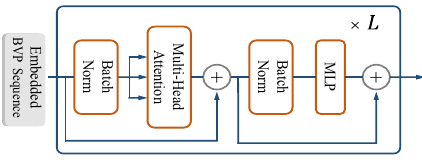
Figure 12. The encoder.